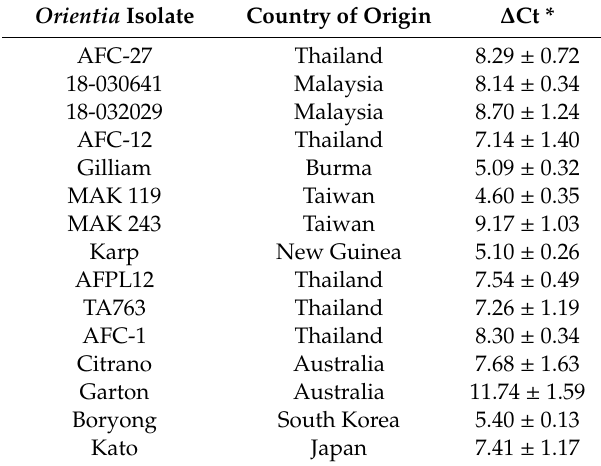
Table 1. Variation of number of copies of the traD gene in various Orientia genomes